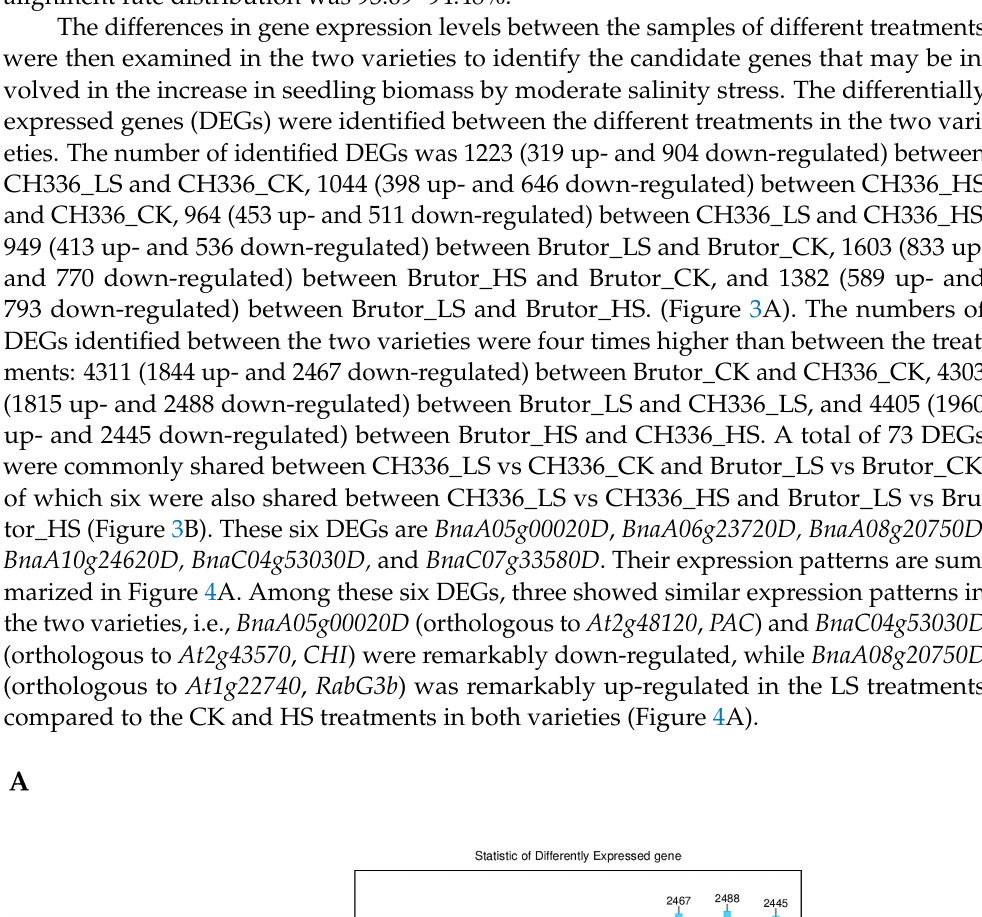
Figure 3. Statistical charts of the di ff erentially expressed genes (DEGs) in two Brassica napus varieties (CH336 and Brutor) under control (CK, 0 mmol L ̶ 1 NaCl), low salt (LS, 25 mmol L ̶ 1 NaCl), and high salt (HS, 180 mmol L ̶ 1 NaCl) stress conditions. ( A ). The column charts of DEGs in each comparison group. The pink and light blue colors indicate the up- and down-regulated DEGs, respectively. The numbers in the column refer to the DEG amounts in each comparison group. ( B ). Venn diagram showing the number of unique and common DEGs in both varieties.